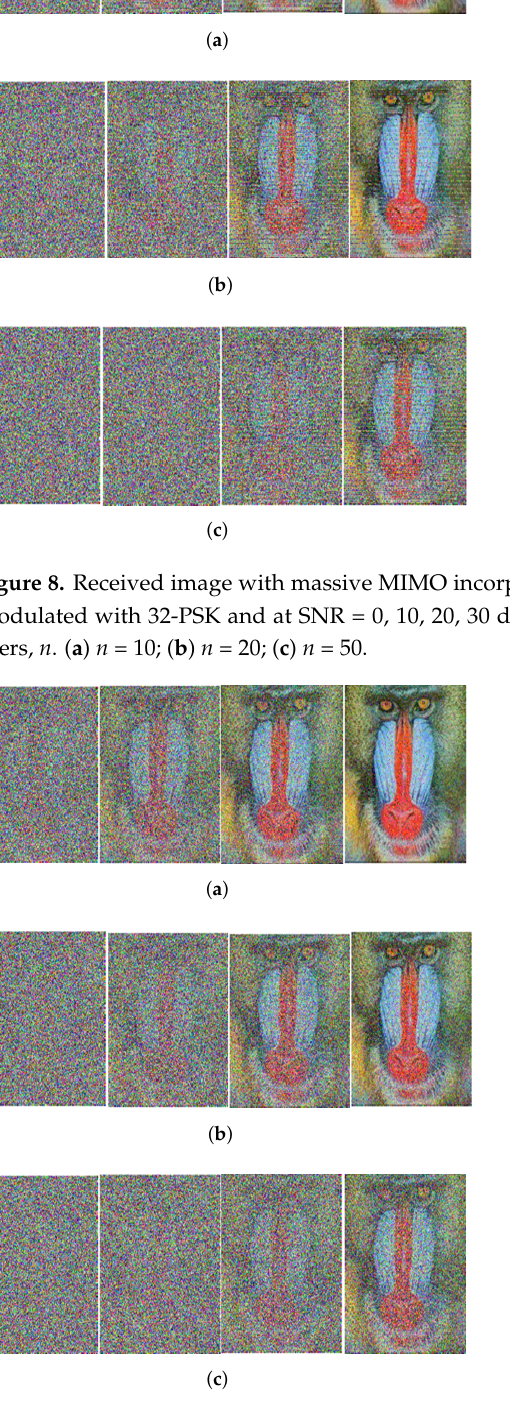
Figure 9. Received image with massive MIMO incorporated FFT-OFDM over a Rayleigh channel, Modulated with 64-PSK and at SNR = 0, 10, 20, 30 dB from Left to Right for different number of users, n . ( a ) n = 10; ( b ) n = 20; ( c ) n =